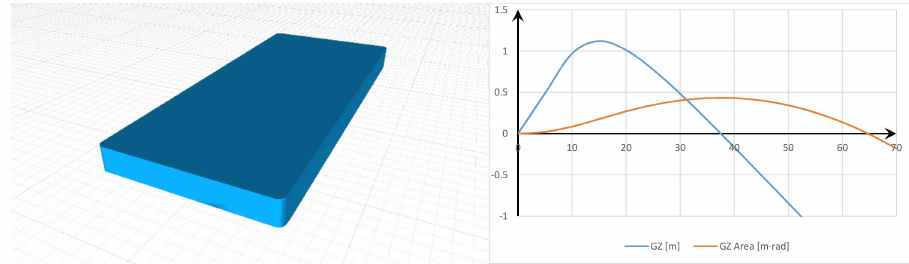
Figure 4. Model 1. GZ and Work (GZ Area) curve for initial condition.